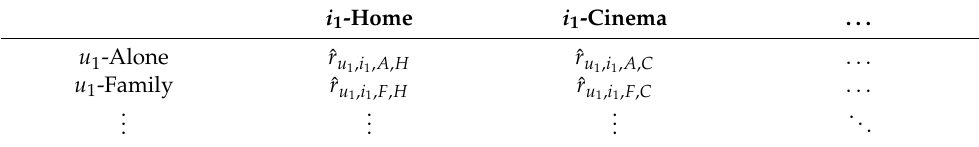
Table 2. Example of User-Item-Splitting that uses the contextual information of Table